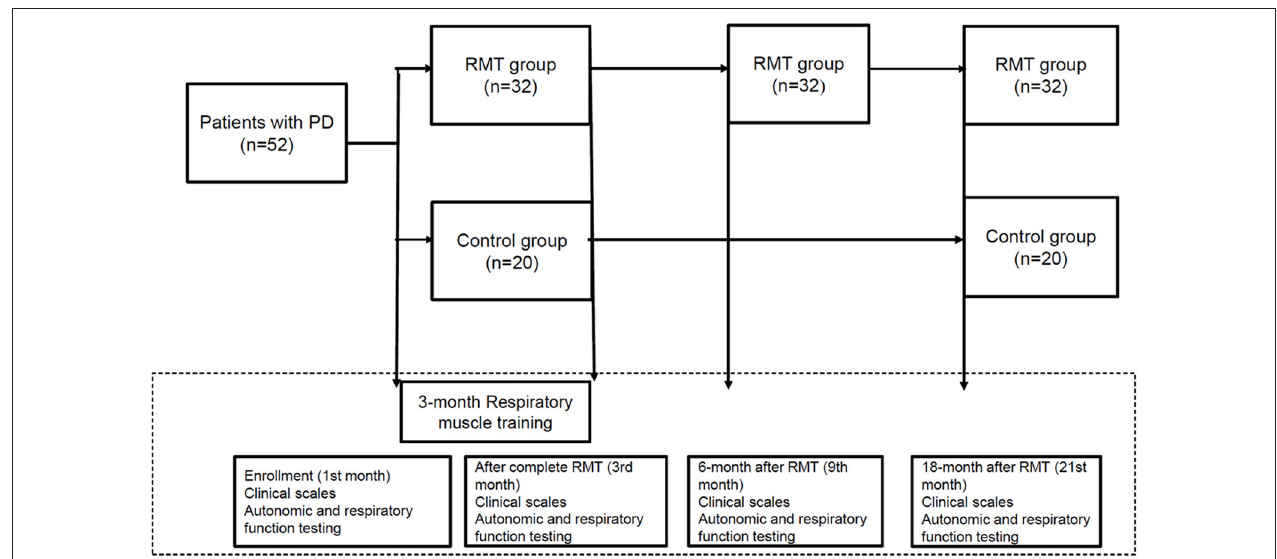
FIGURE 1 | Flow chart of the study protocol.